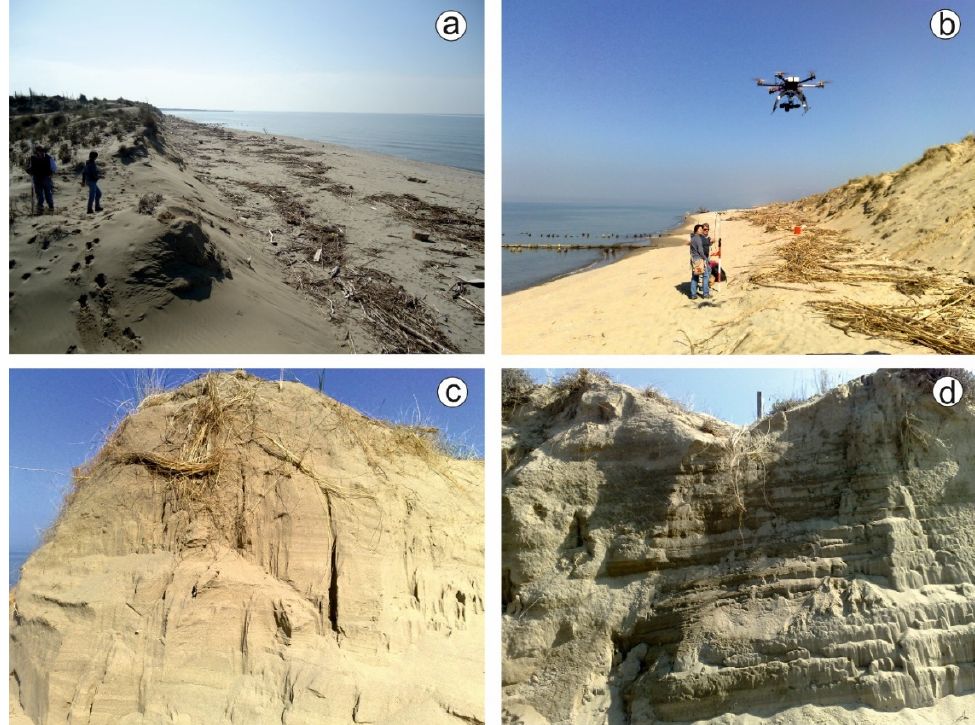
Figure 9. The geomorphology and sedimentary characteristics of the coastal stretch affected by erosion. The short backshore and the steep active dune flank ( a , b ), aeolian beds ( c ) and seaward inclined marine beds ( d ) exposed in natural trenches.